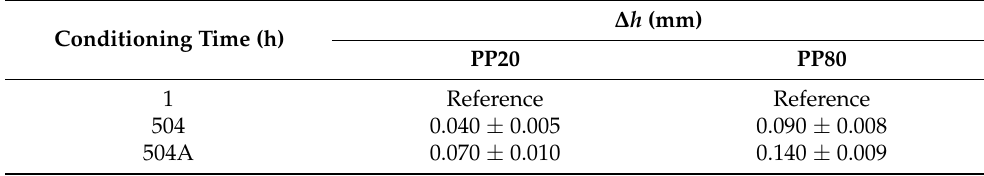
Table 2. Changes in depth of sink marks in the measurement section of conditioned PP